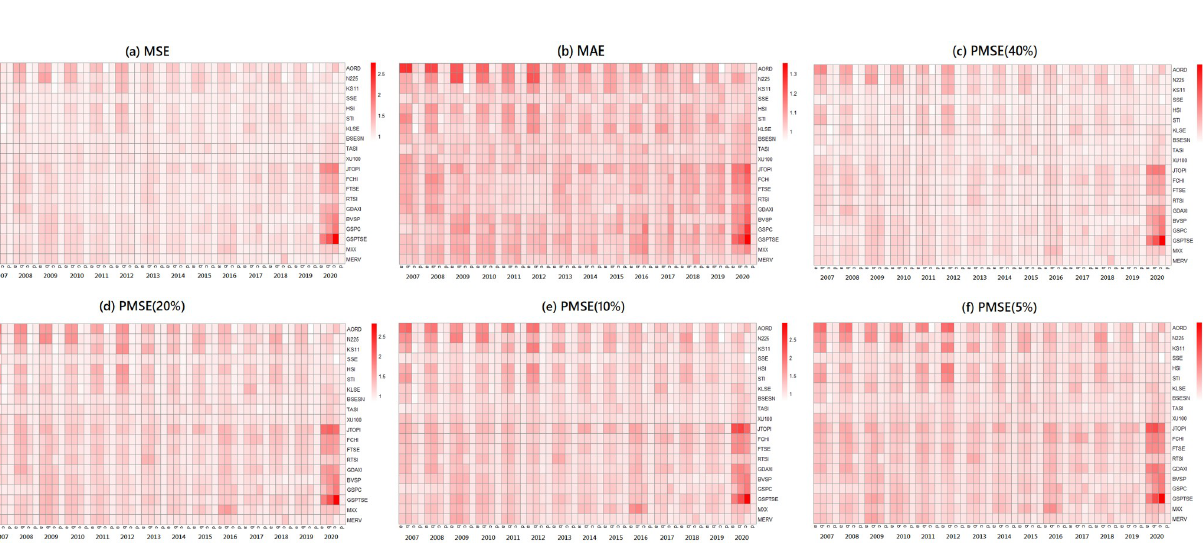
Fig 4. The fitted performances of the 4 models for the 20 indices from 2007 to